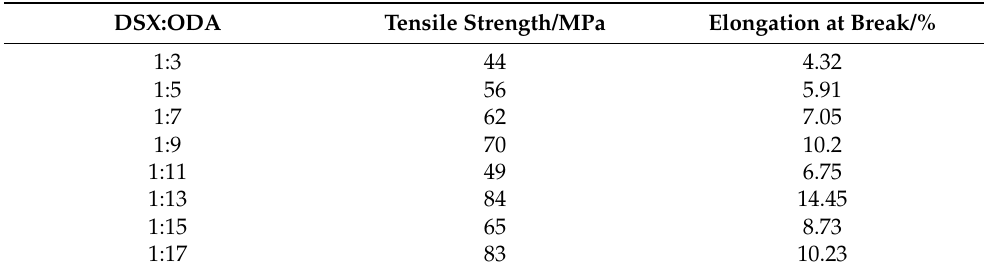
Table 4. Mechanical properties of PI films in group 1.